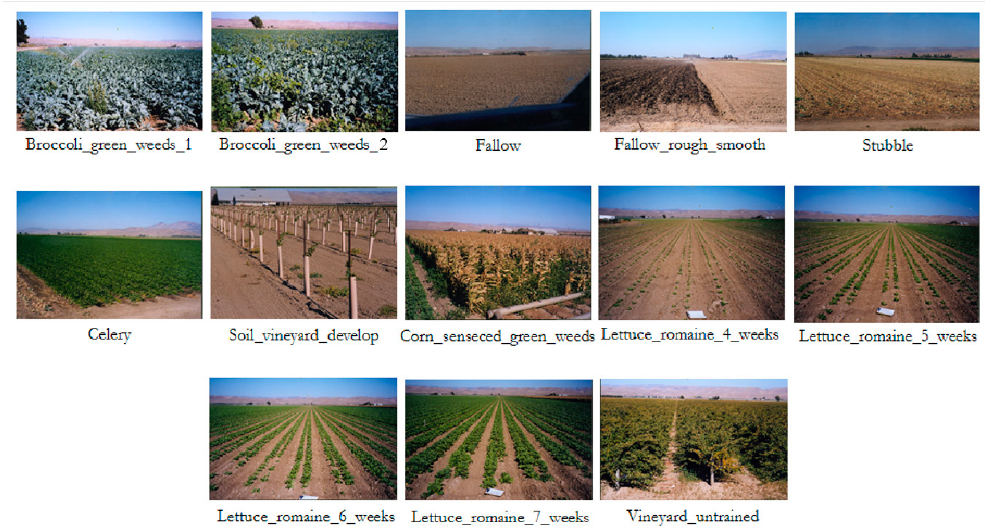
Figure 10. Photograph of the selected classes in the region of the imaging.